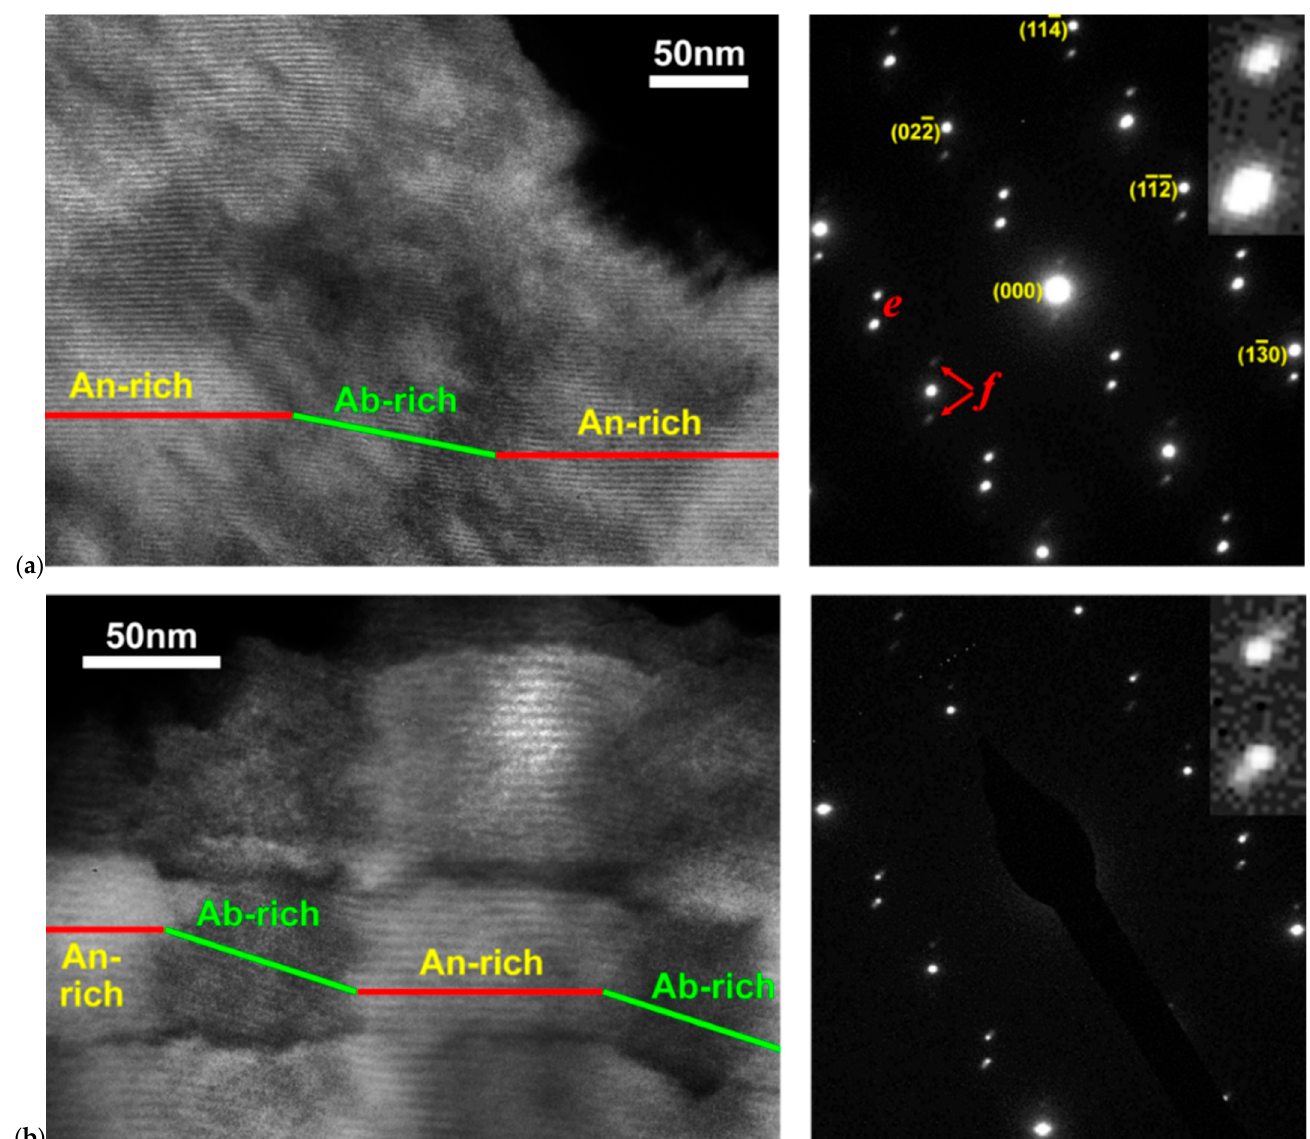
Figure 1. High-resolution dark-field TEM images of both red-iridescent ( a ) and blue-iridescent ( b ) areas in sample Gem113, showing both the exsolution lamellar boundaries and the modulation e -fringes. The corresponding selected-area diffraction patterns (SAED) of the [311] zone axis are shown to the right of the images. The blue-iridescent sample shows a much larger change in the modulation direction and period compared to the red-iridescent sample, which is also reflected in the SAED pattern.